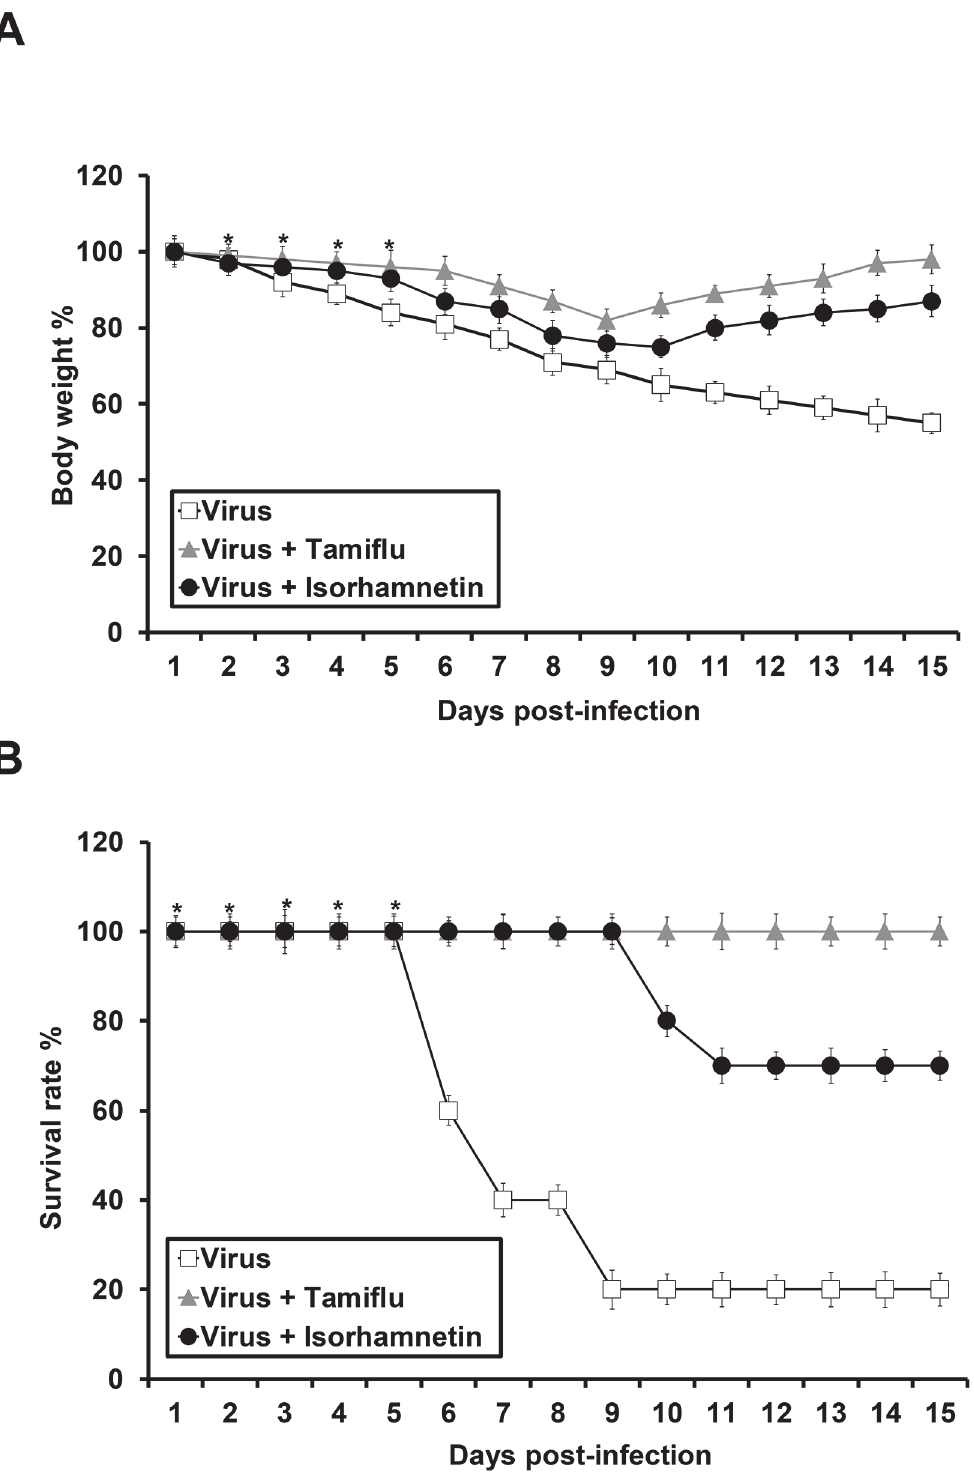
Fig 6. In vivo antiviral activity of isorhamnetin against influenza virus infection. (A)The rate of loss in body weight of six-week-old female mice(C57BL/ 6)after influenza A/PR/8/34 (H1N1) virus infection and isorhamnetin treatment, and Tamiflu was used as a positive anti-influenza material; * P < 0.05. (B) The survival rate in six-week-old female mice (C57BL/6) after influenza A/PR/8/34 (H1N1) virus infection and flavonoids treatment. * P < 0.05.